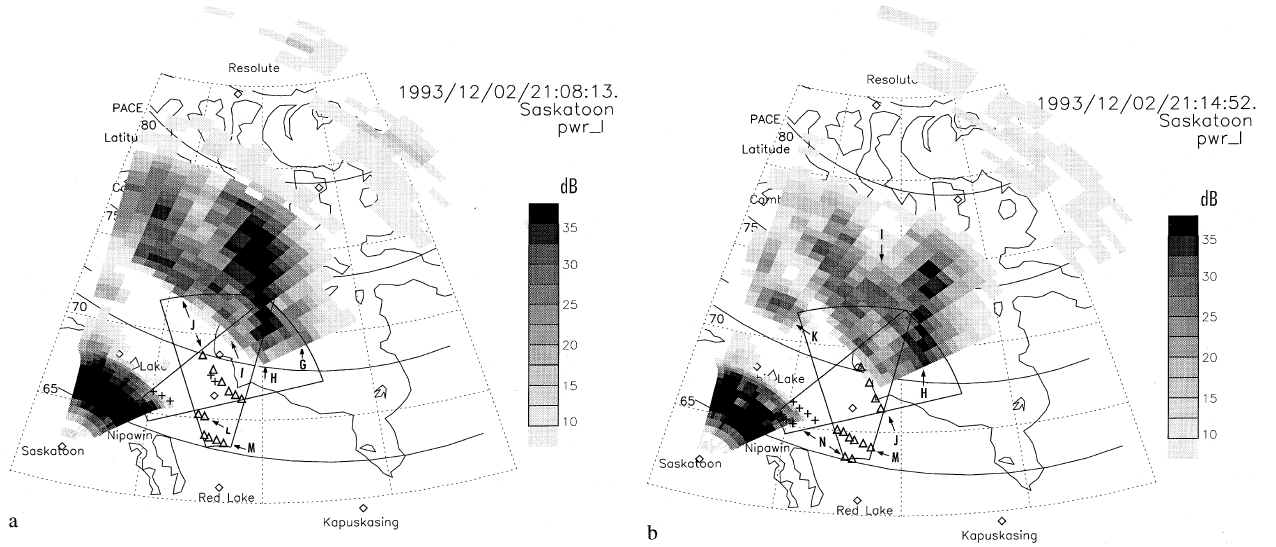
Fig. 14a, b. The Saskatoon SuperDARN radar maps of backscatter power showing the location of patches ( G-K ) at a 2108 UT and b 2114 UT. The positions of the BARS E-region backscatter bands are shown superposed in the Nipawin ( crosses ) and Red Lake ( triangles ) radar fields